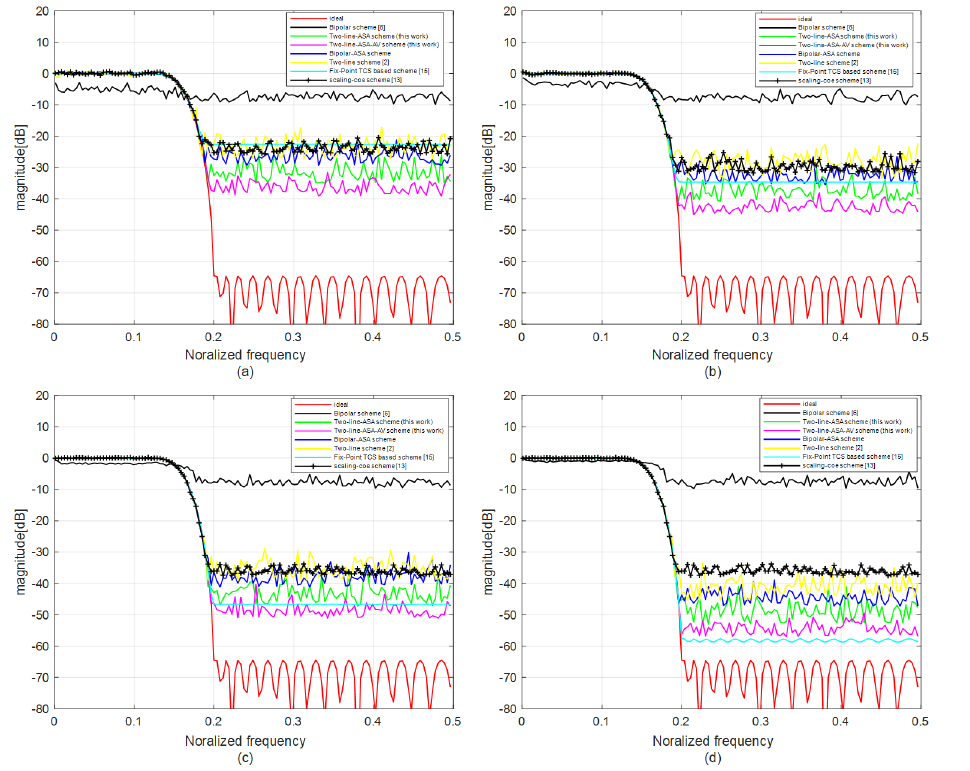
Figure 12. Magnitude responses of 47th-order SFIR filters: ( a ) N sto = 2 8 (Fix-Point 8 bits), ( b ) N sto = 2 10 (Fix-Point 10 bits), ( c ) N sto = 2 12 (Fix-Point 12 bits), and ( d ) N sto = 2 14 (Fix-Point 14 bits).